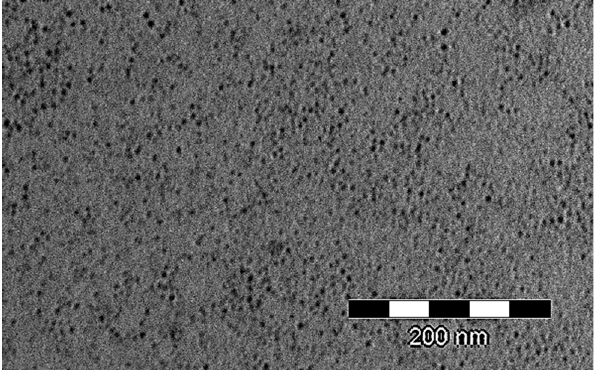
Figure 5. TEM image of crosslinked INVITEMA3/2 h nanogrid.